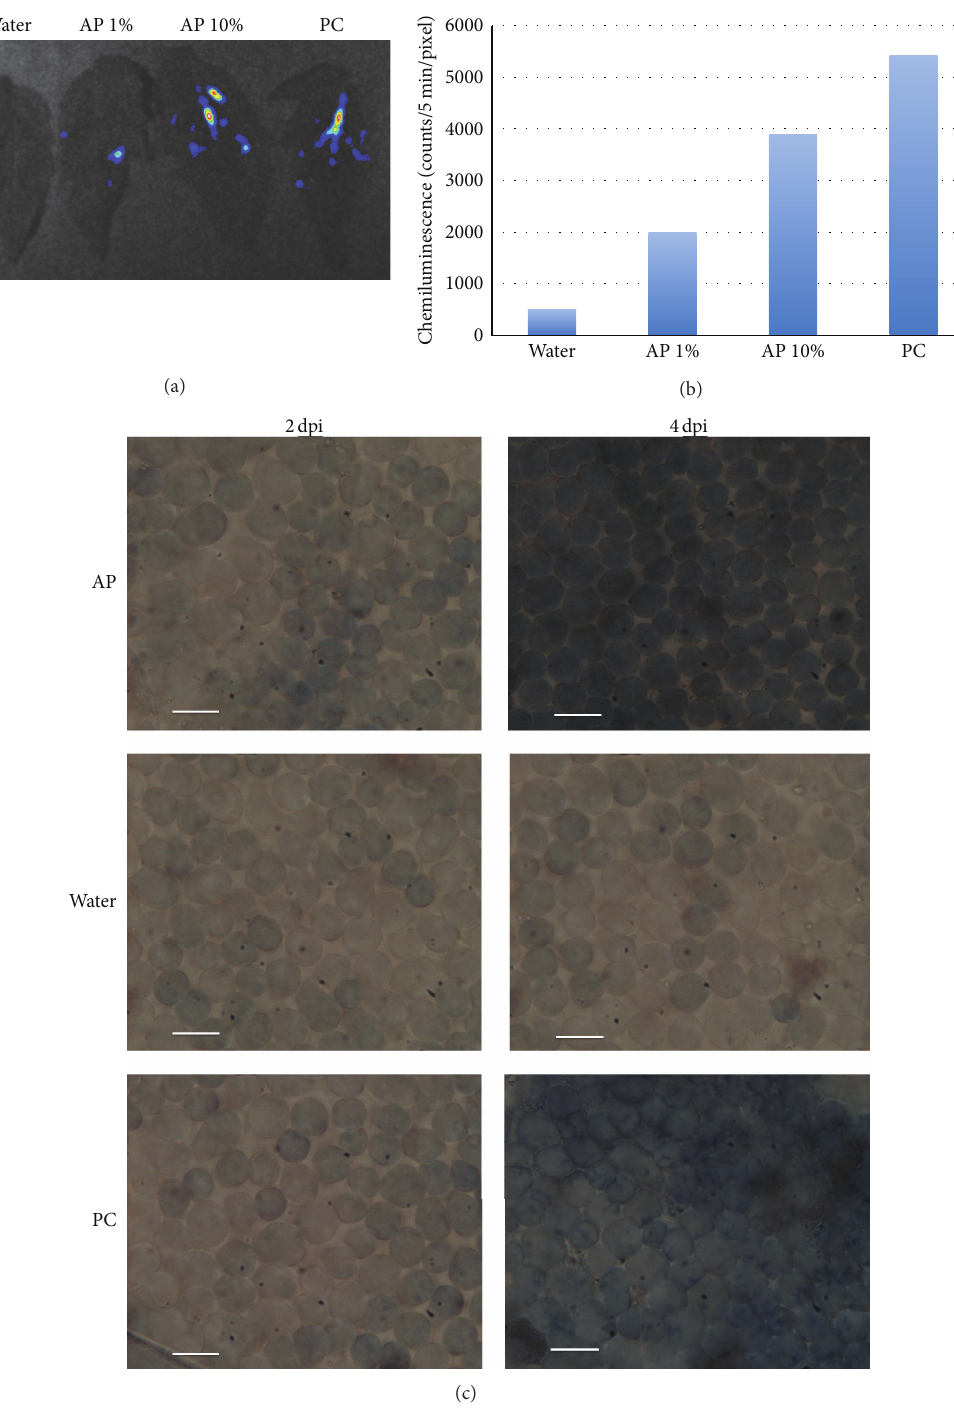
Figure 5: AP induced resistance reaction in tomato plants. (a) Solanum lycopersicum plants were sprayed with AP 1%, AP 10%, and H 2 O (as a negative control) or hyphal wall components (HWC) of P. infestans (as a positive control), and 90 min later the luminol derivative L-012 (0.5 mM L-012 in 10mM MOPS-KOH (pH 7.4)) was infiltrated to the abaxial surface of the leaves using a needleless syringe. Chemiluminescence was monitored using a photon image processor equipped with a sensitive CCD camera in a dark chamber at 20 ∘ C. Representative graphs were taken 90 mpt. (b) Data were quantified using the U7501 program. Shown data are the average of three repeated experiments. Bars with different letters are significantly different at ( 𝑃 < 0.05 ). (c) S. lycopersicum leaves were infiltrated through the abaxial surface using a needleless syringe with AP 10% and H 2 O (as a negative control) or HWC (0.5 mg/mL) (as a positive control) and incubated for 2 or 4 days and then visualized for HR-like cell death using trypan blue staining method as described in Section